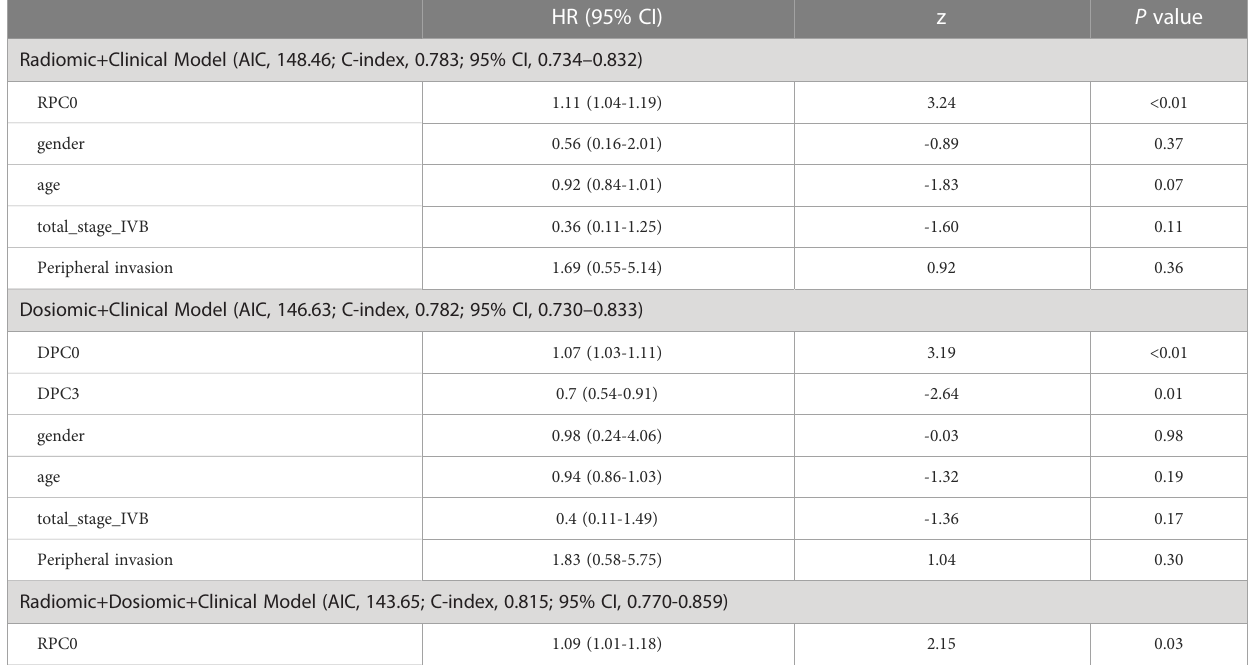
TABLE 3 Multivariate Cox Regression Analysis for the Radiomic+Clinical Model, Dosiomic+Clinical Model and Radiomic+Dosiomic+Clinical Model